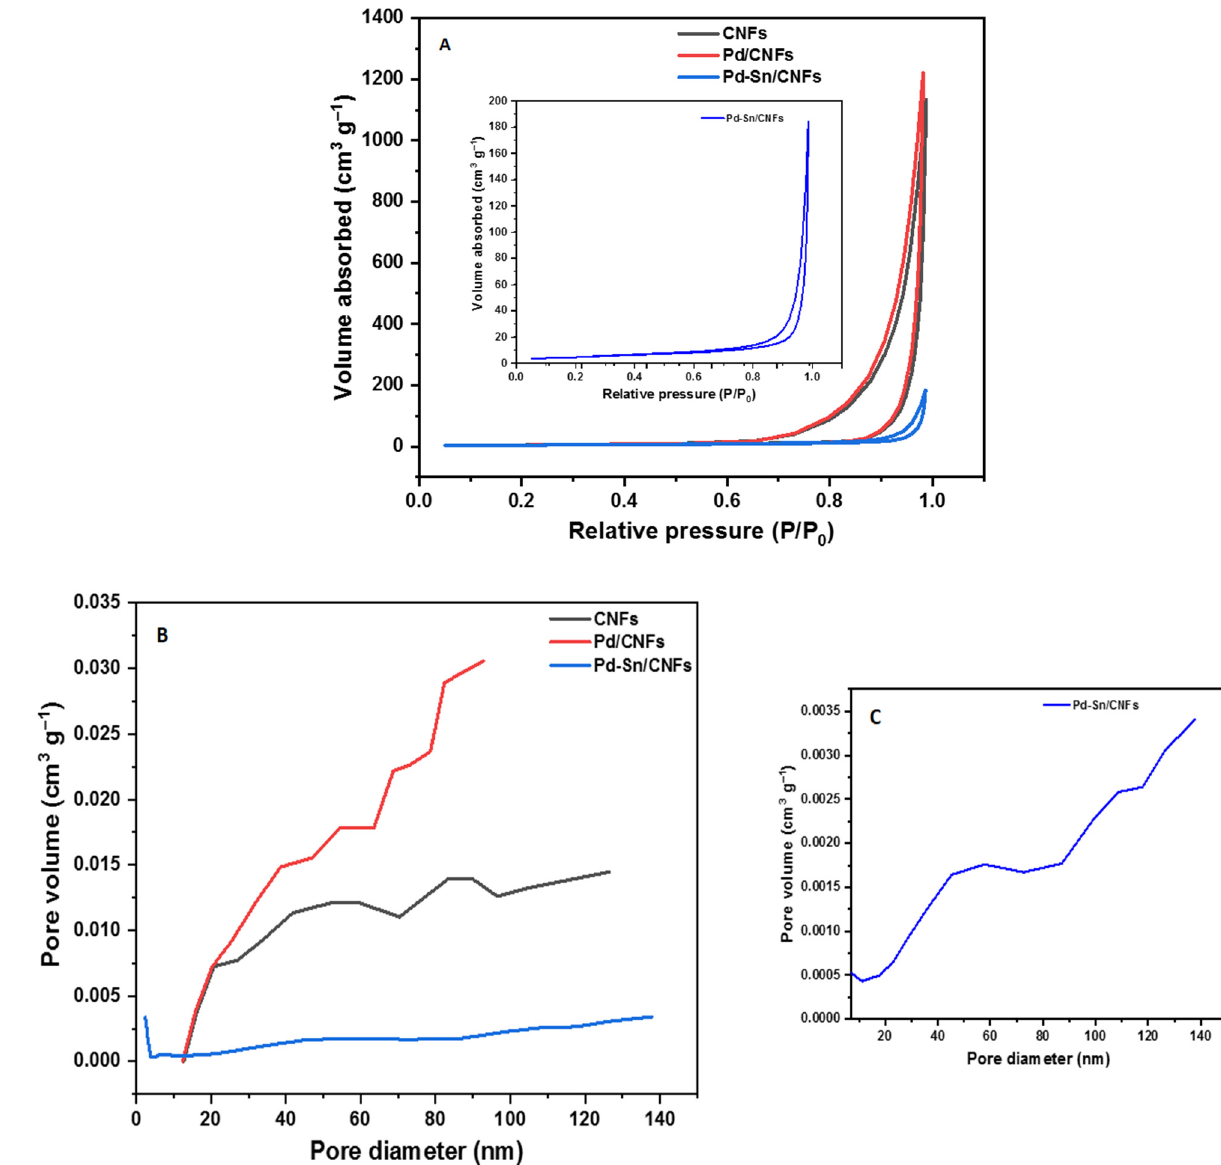
Figure 7. Nitrogen adsorption-desorption isotherms of CNFs support, and Pd/CNF and Pd-Sn/CNF (insert) electro-catalysts ( A ), pore size distributions of CNFs support, and Pd/CNF and Pd-Sn/CNF electro-catalysts ( B ) and Pd-Sn/CNFs electro-catalyst ( C ).